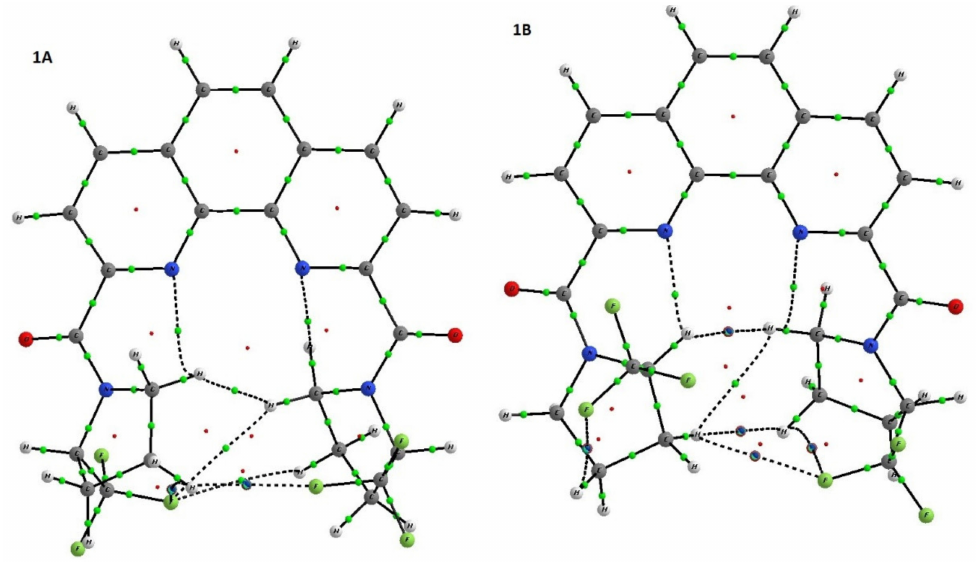
Figure 6. The molecular graph of two conformers of 1 . The CP (3,–1) are shown by green spheres. Thus, the stabilization of conformation is mainly governed the intramolecular H-bond and, although the difference in energy of two conformers is negligible, the conformation obtained in 1B · H 2 O was also observed in the case of meso- 2B, which crystallized without any solvate molecules (Figure 7).